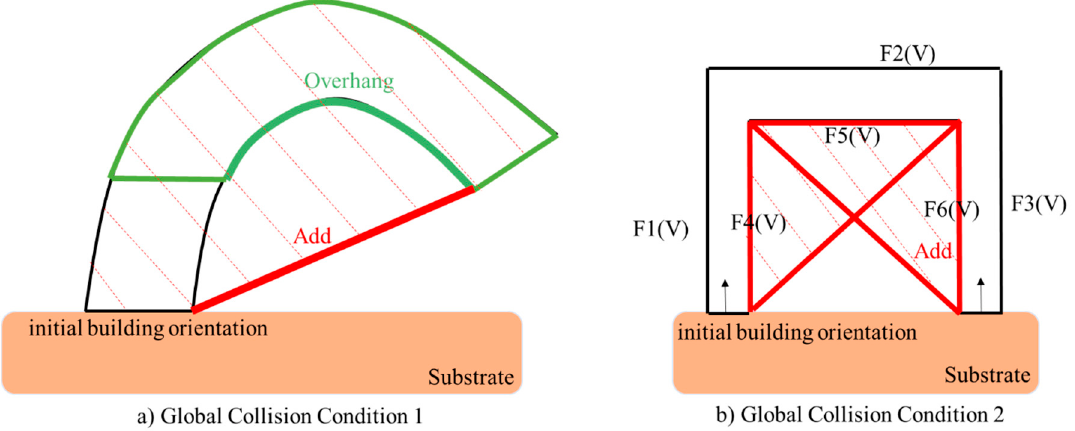
Figure 9. Two global collision conditions that can be detected and avoided by Algorithm 2.